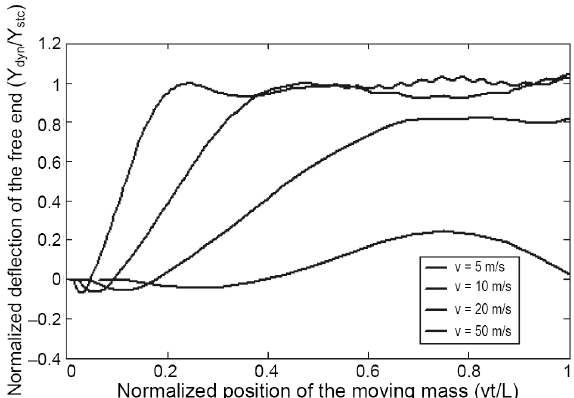
Fig. 6. Variation of the normalized deflections at the free end with respect to normalized position of moving mass for differ- ent values of the velocity of the moving mass. L 0 = 4 m, γ = 0.5, M = 1000